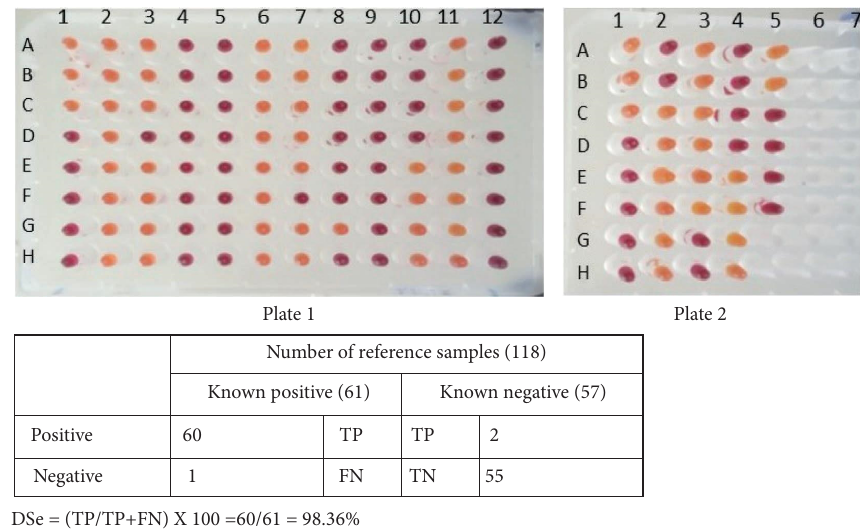
Figure 10: Determination of analytical sensitivity, specifcity, positive predictive value, and negative predictive value for the colorimetric- RVFV-UDG-RT-lamp assay compared with qRT-PCR and IgM capture